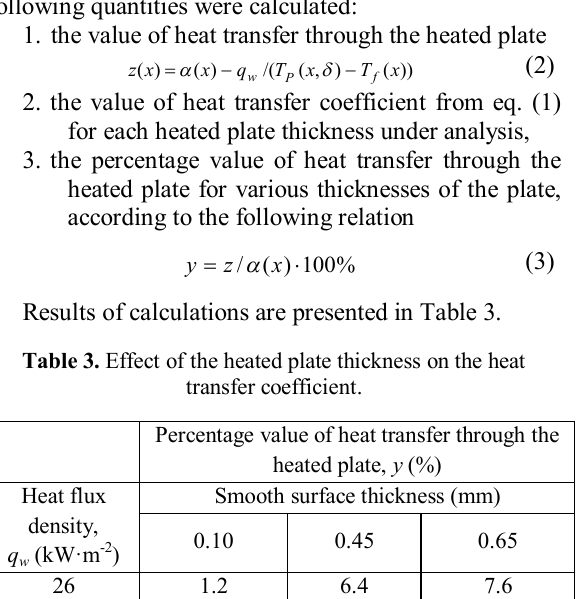
Fig. 6. Heat transfer coefficient vs. distance from the minichannel length obtained for the subcooled boiling region for three tested thicknesses of the heated plate, q w = 26 kW∙m -2 .